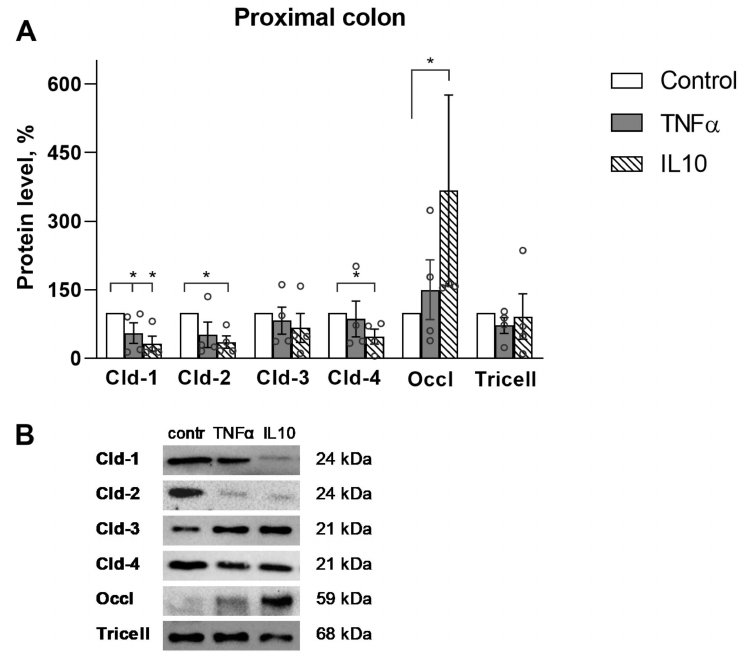
Figure 3. Western blot analysis of TJ proteins in the proximal colon. ( A ) Densitometric analysis revealed decreased Cld-1 under the action of TNF α , decreased claudin (Cld)-1, -2 and -4 and